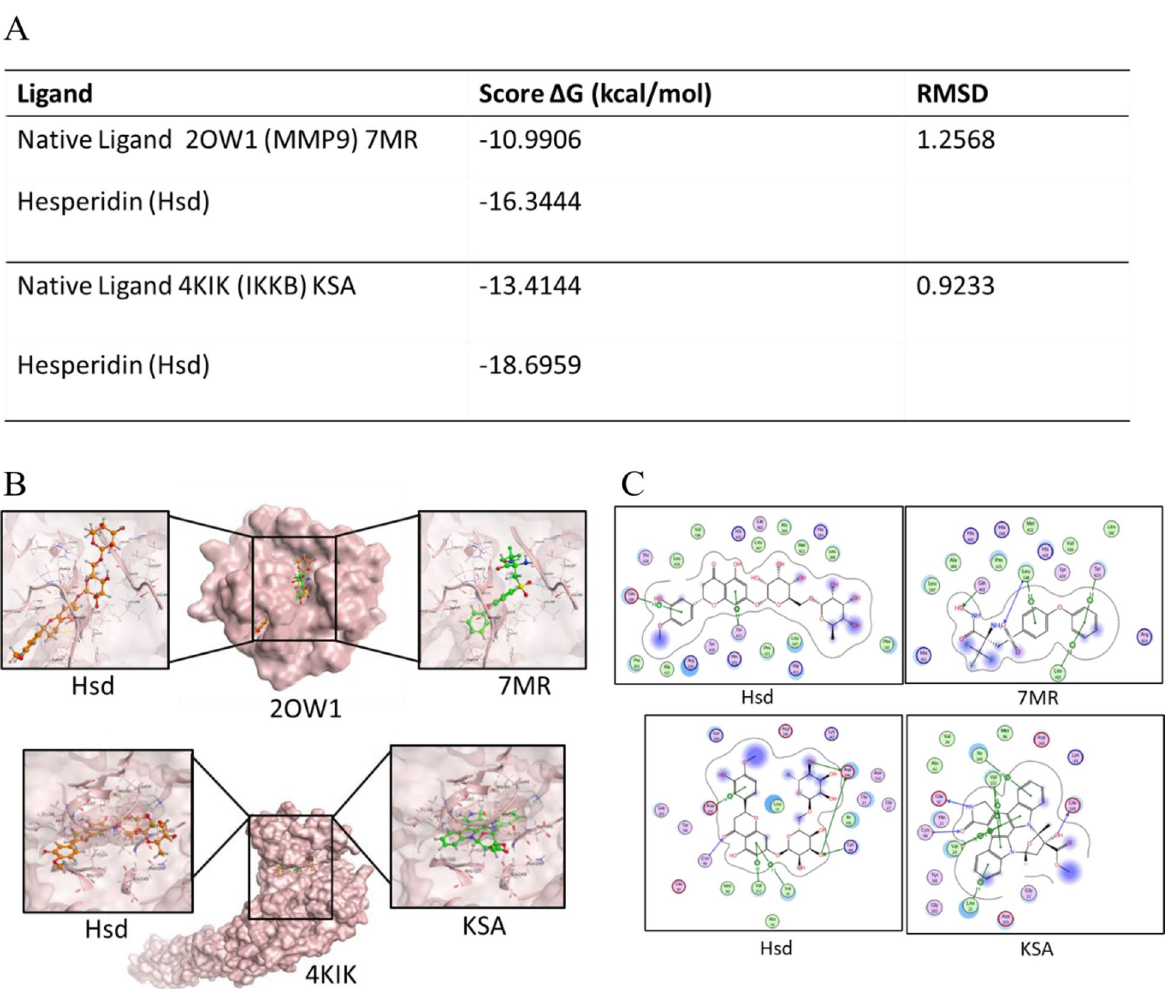
Fig. 6 The molecular docking simulation of Hsd towards MMP 9. A Docking score of Hsd, native ligand 7MR, and native ligand KSA. B 3D visualization of Hsd and each native ligands of 2ow1 (crystal protein of MMP 9) and 4KIK (crystal protein of IKKB). C 2D visualization of Hsd interaction towards MMP 9 and